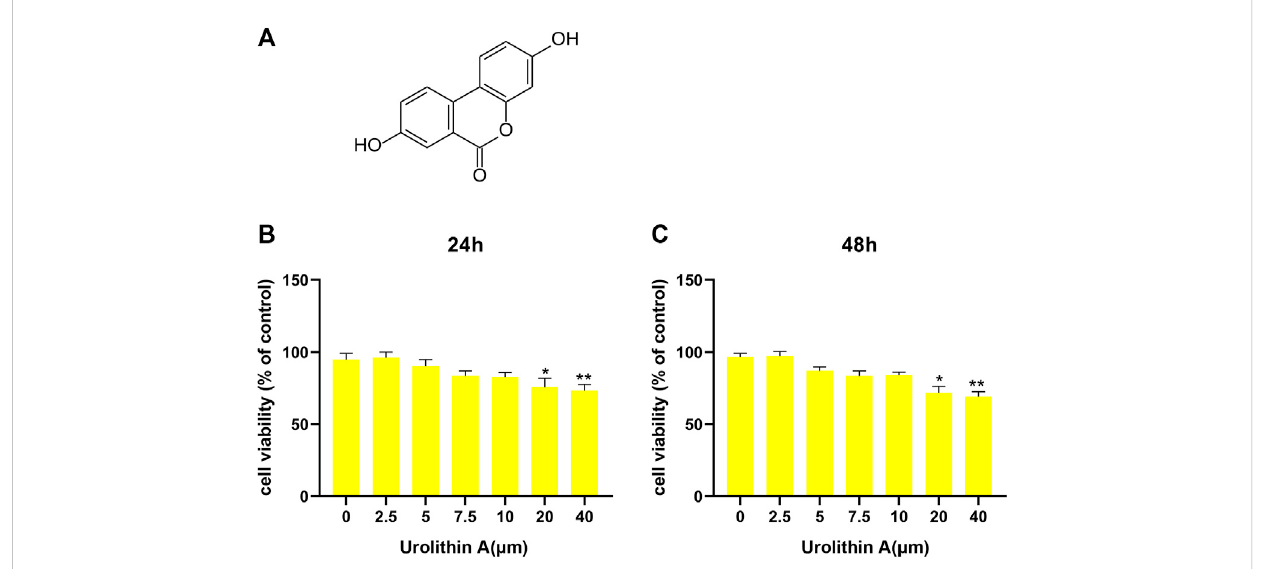
FIGURE 1 Effects ofUA treatmenton theviability of BEAS-2B cell. (A) The molecular formula of Urolithin A (UA). (B,C) CCK-8 results of BEAS-2B cells after 24/ 48 h UA treatments at diverse doses. Results were Shown as mean ± SD. * p < 0.05, ** p < 0.01 in comparison to the control